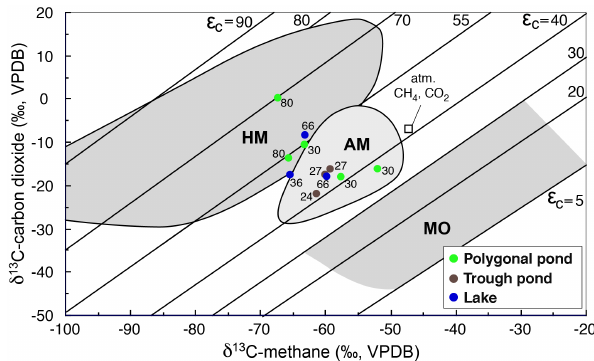
Figure 8. Carbon isotope composition ( δ 13 C) of CH 4 ( x axis) and CO 2 ( y axis) emitted by the sampled ponds and lakes. HM = hydrogenotrophic methanogenesis; AM = acetoclastic methanogenesis; MO = methane